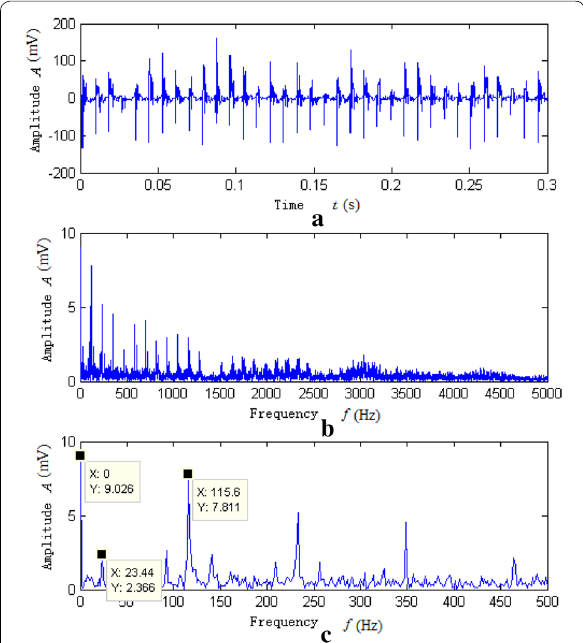
Figure 18 Low frequency component of N205 with severe defect on the outer race: ( a ) time waveform, ( b ) FFT spectrum, ( c ) local spectrum